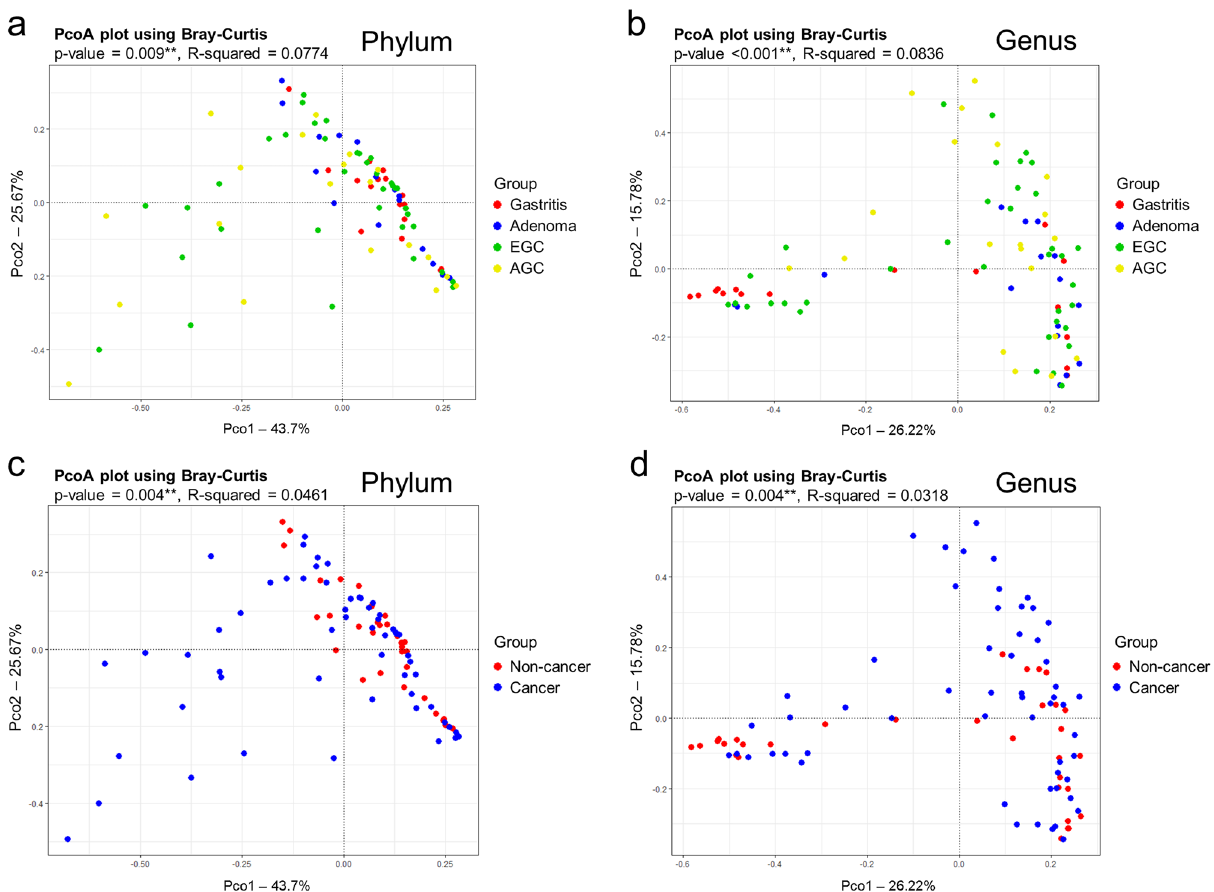
Figure 2. Analysis of beta diversity based on the Bray–Curtis dissimilarity measure and visualization by PCoA plot. The percentage of diversity captured by each coordinate is indicated in the axis. The microbial compositions were compared between the four groups (GA, GAD, EGC, and AGC) ( a ) at the phylum level and ( b ) at the genus level. The microbial compositions were also compared between the cancer group (EGC and AGC) and non-cancer group (GA and GAD) ( c ) at the phylum level and ( d ) at the genus